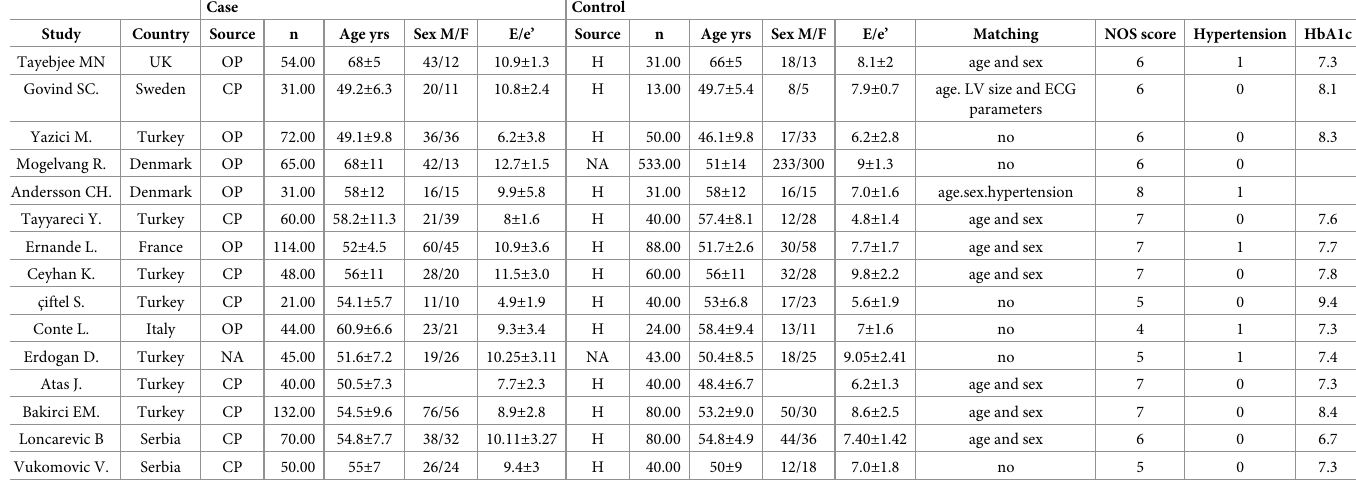
Table 1. Characteristics of enrolled case-control studies of averaged E/e’ ratio in type 2 diabetes patients compared to non-diabetic controls. OP: outpatient; CP: consecutive patient; H: healthy control. NOS: Newcastle-Ottawa scale. Case: type 2 diabetic patients; Control: healthy non-diabetic